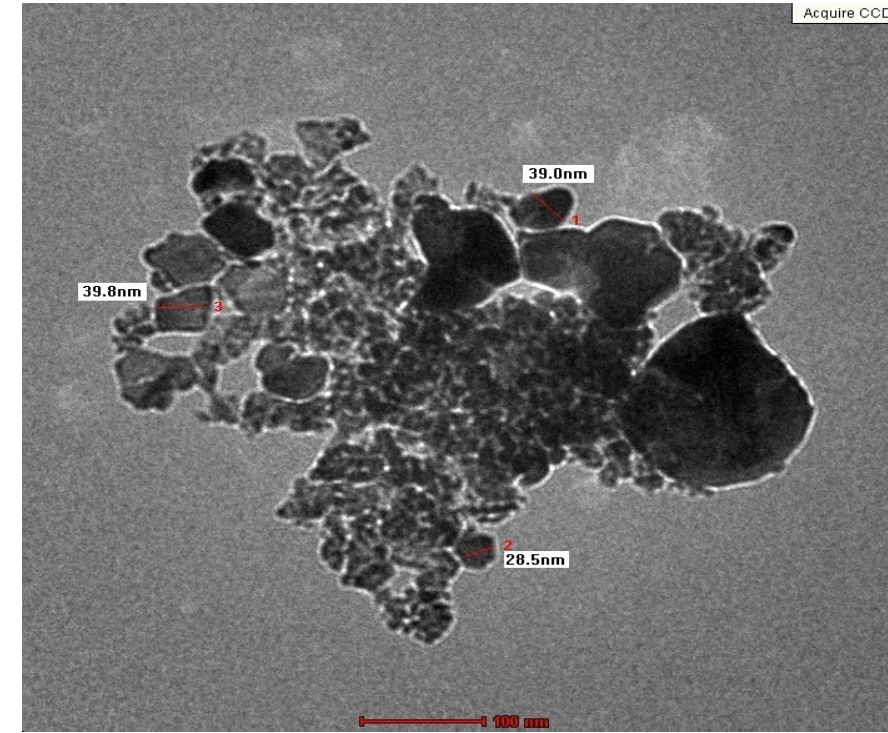
Fig. 6. TEM image of ZnWO4/ZrO